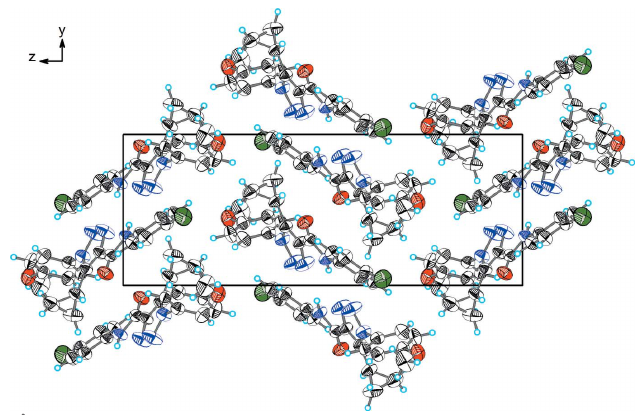
Figure 3 A view along the a axis of the crystal packing of the title